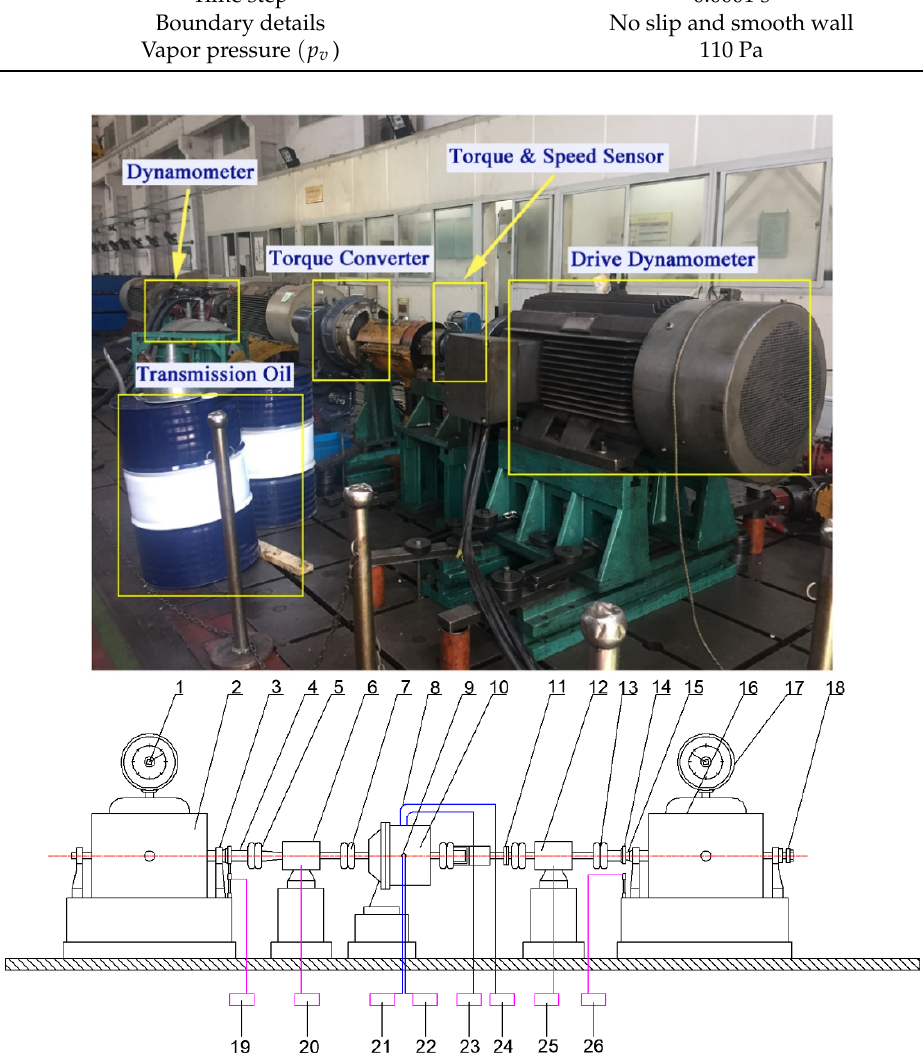
Figure 3. Test rig for the HTC (1—drive dynamometer meter, 2—drive dynamometer, 3, 14—fluted disc, 4, 15—speed transducer, 5, 7, 11, 13—coupler, 6, 12—torque transducer, 8—oil inlet, 9—oil outlet, 10—torque converter, 16—dynamomter, 17—dynamometer meter, 18—mechanical brake, 19, 26—speed meter, 20, 25—torque meter, 21, 23—pressure meter, 22, 24—temperature meter).